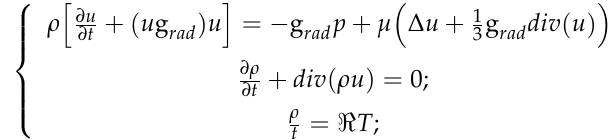
Figure 12. The dependence of the bearing capacity of a magnetic bearing on the current at zero displacement.